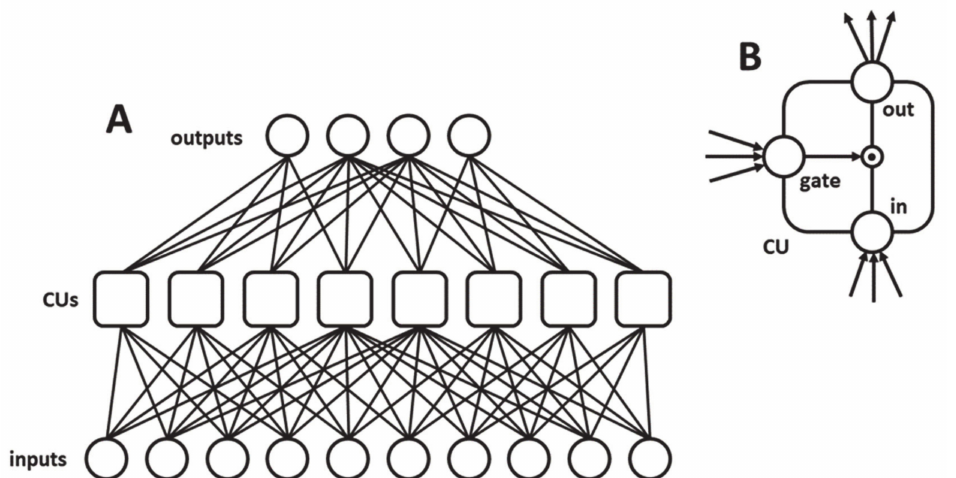
Figure 1. Drug combination potencies were predicted using trained artificial neural networks (ANNs) composed of simple and compound units. ( A ) The ANNs had three layers: input, internal, and output. All input units connected to all internal units, and all internal units connected to all output units. ANNs trained on the Religious Orders Study and Rush Memory and Aging Project (ROSMAP) dataset had 113 input and 25 output units, while ANNs trained on the National Alzheimer’s Coordinating Center (NACC) dataset had 101 input and 57 output units. Both ANNs had 80 internal units. ( B ) The internal units were compound units (CUs). Each CU had its own in, out, and gate unit. Both the in and the gate units of each CU received connections from all input-layer units. The gate unit modulated the activation of the CU in unit (i.e., gate unit output multiplies in unit output, signified as • ) before it was sent to the CU out unit. Each CU out unit connected to every output-layer